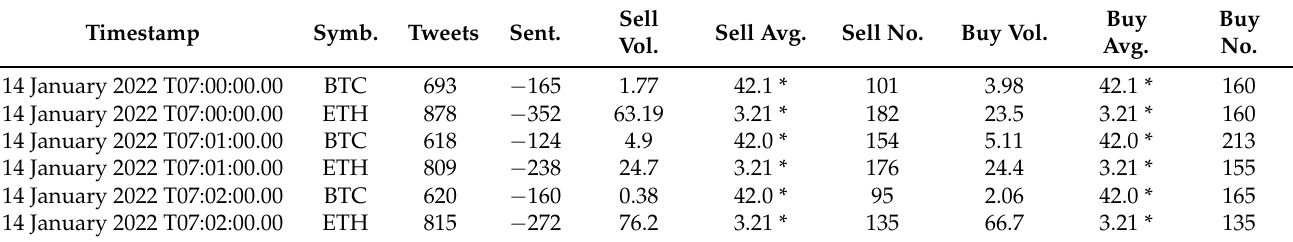
Table 2. Relation between Twitter and CryptoCompare datasets on a time basis of minutes.